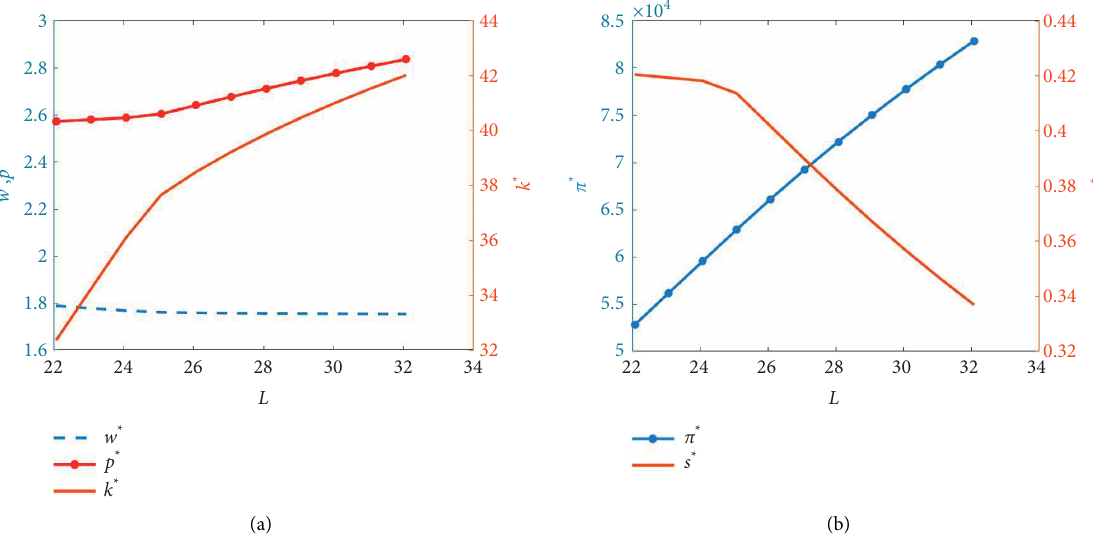
Figure 10: Sensitivity analysis of endogenous variables in terms of L . (a) p ∗ , w ∗ , and k ∗ . (b) s ∗ .